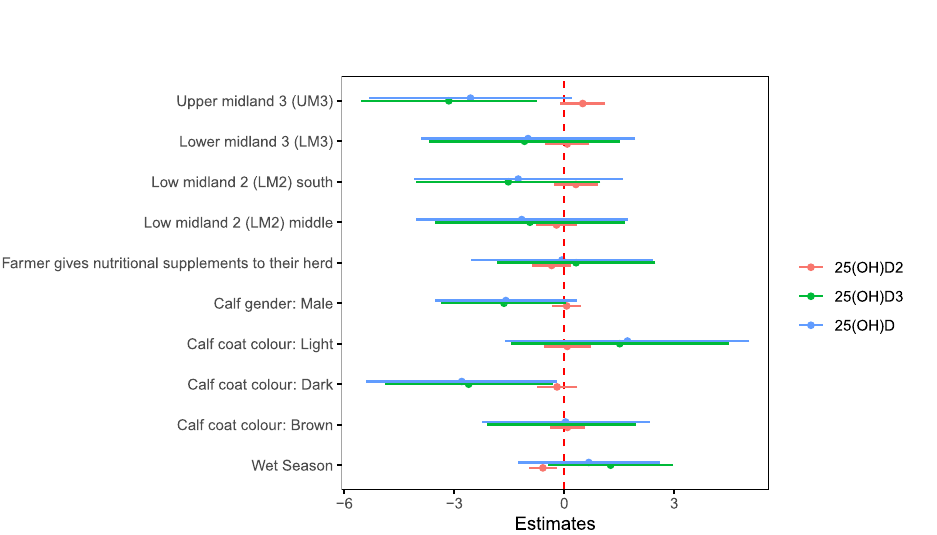
Figure 7. Estimates of effect sizes for the effect of wet/dry season on serum 25(OH)D concentration after accounting for the calf level factors. Error bars represent the 95% confidence intervals. Average model estimates are calculated for variables in the top model set (models with a cumulative Akaike weight ≤ 0.95, Supplementary Table 3 and Supplementary Fig. 4). Factors are considered important if their confidence intervals do not span one, as indicated by the dotted vertical